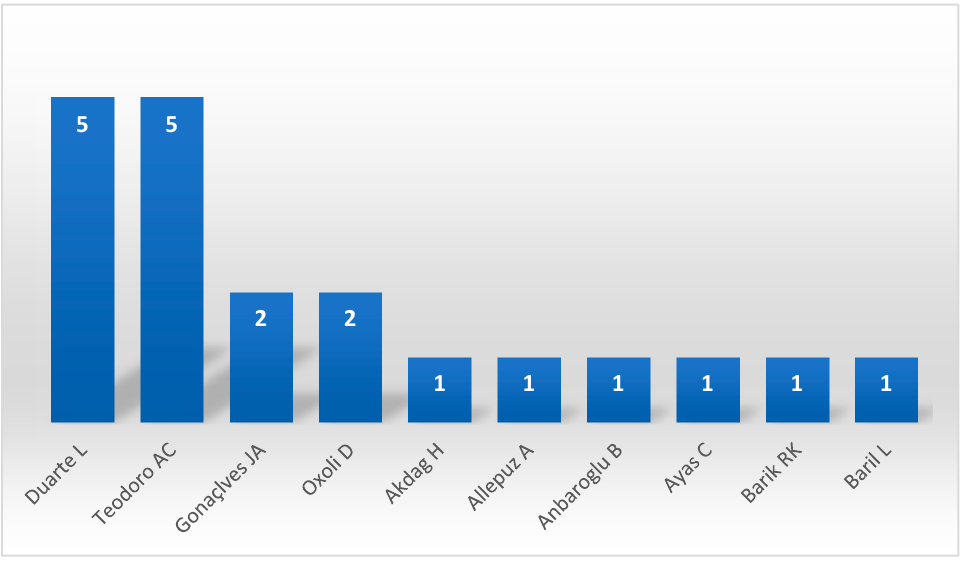
Figure 4. The number of occurrences of publications based on GIS open-source applications in the 10-year period, by author.